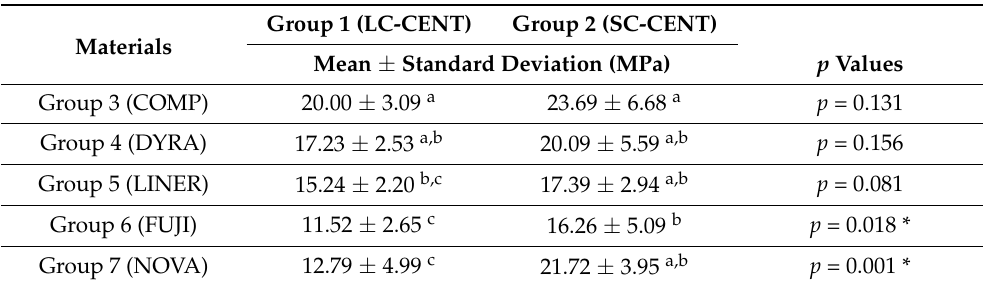
Table 4. Microtensile bond strength ( µ TBS) values of dental restorative materials bonding to light and self-cured Cention N